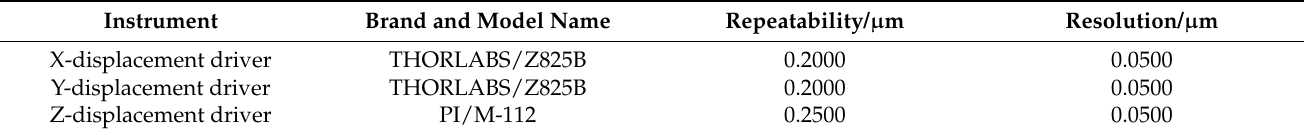
Table 1. Driver brand name and performance parameter.